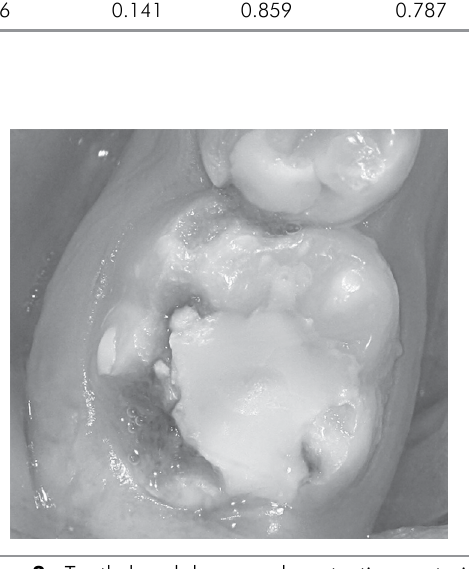
Figure 1. Atypical protective satisfactory restoration at 12-month evaluation.